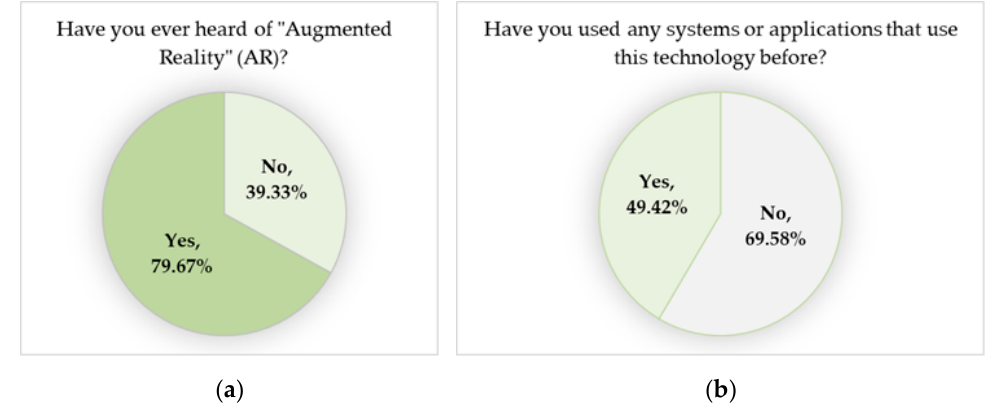
Figure 8. Poll results for the first two items of the questionnaire.